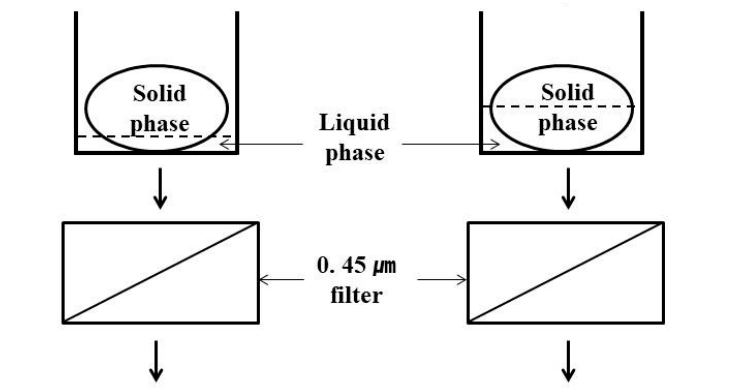
Figure 1. Schematic diagram of the experimental